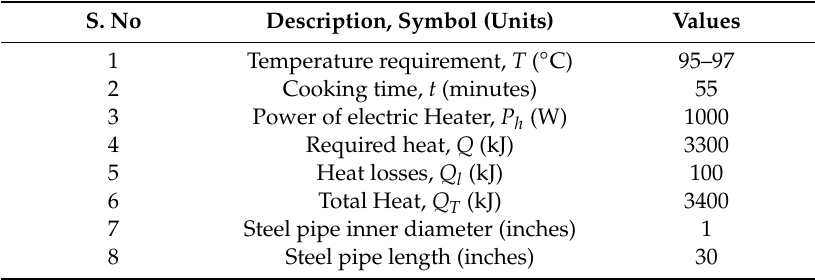
Table 1. Design requirement for